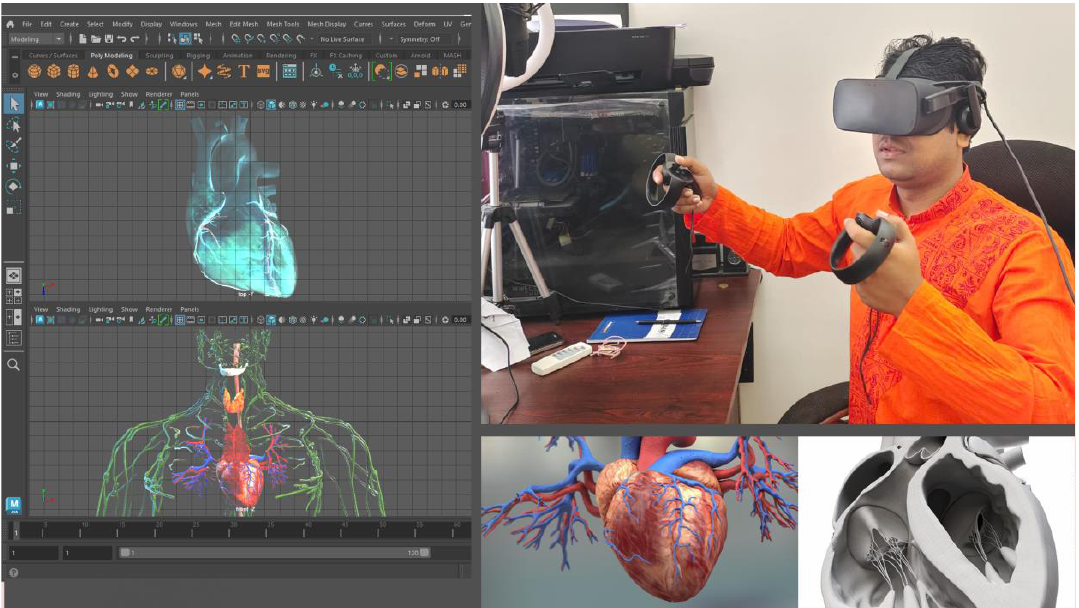
Figure 2. Interactive 3D human body to learn and practice the medical concepts. ARCS [14] model is a motivational design technique that combines four categories: attention (A), relevance (R), confidence (C), and satisfaction (S), Figure 3.